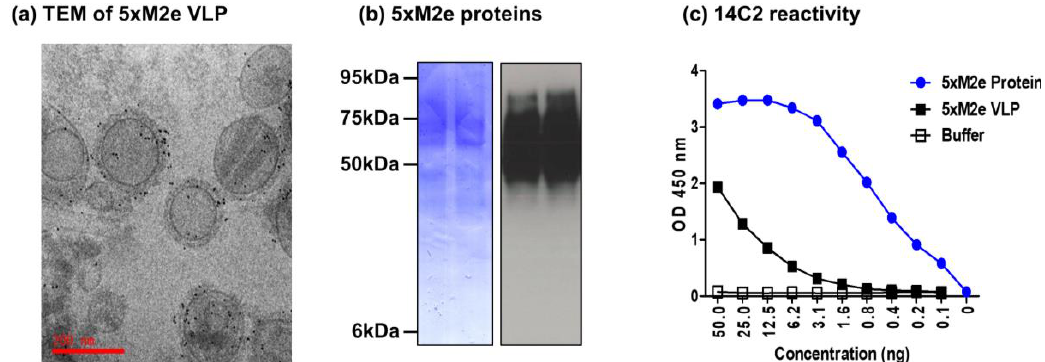
Figure A1. Characterization of VLP and protein of 5xM2e. ( a ) Transmission electron microscopy (TEM) of 5xM2e VLP. Bar indicates a size of 200 nm. ( b ) SDS-PAGE and Western blot of 5xM2e proteins. Oligomeric forms 5xM2e proteins were observed. ( c ) The reactivity of VLP and protein of 5xM2e to 14C2 mAb were determined by ELISA. The concentrations are indicated as coated onto the ELISA plates. Buffer: negative control.